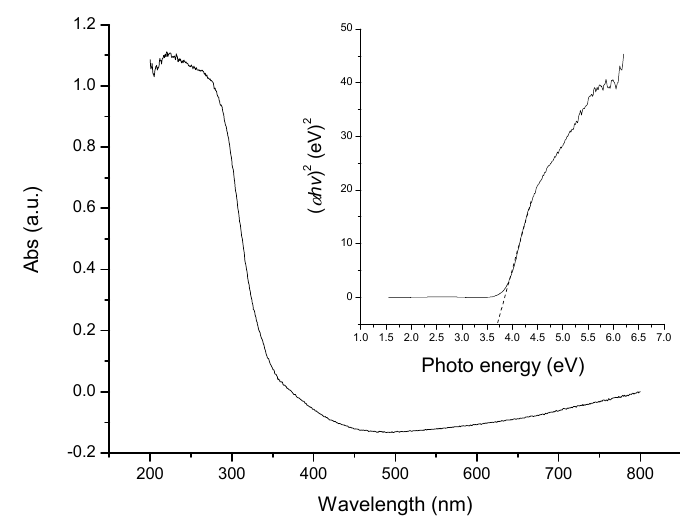
Figure 4. UV absorption spectrum of the SnO 2 nanoparticles.